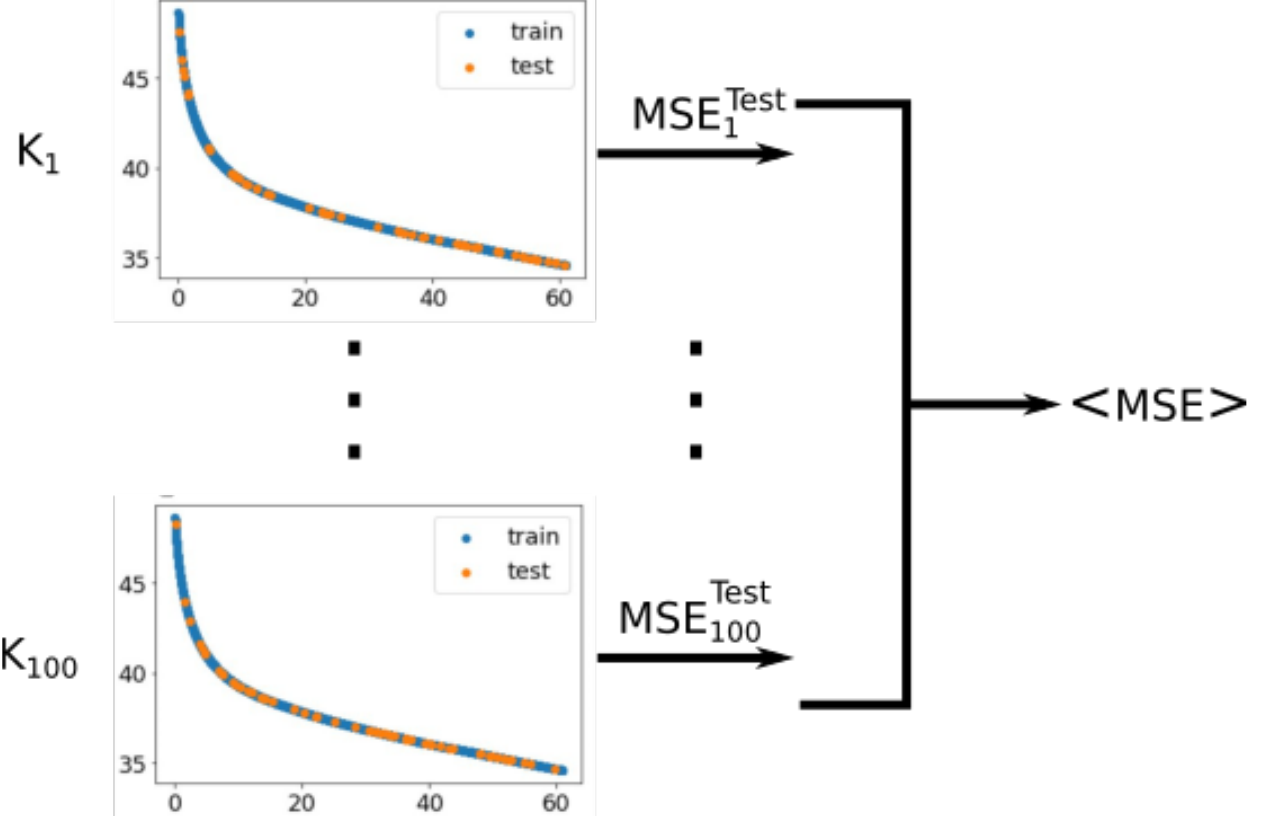
Figure B2. Calculation of MSE as a criterion of cross validation to evaluate the quality of the GMM model fitting.